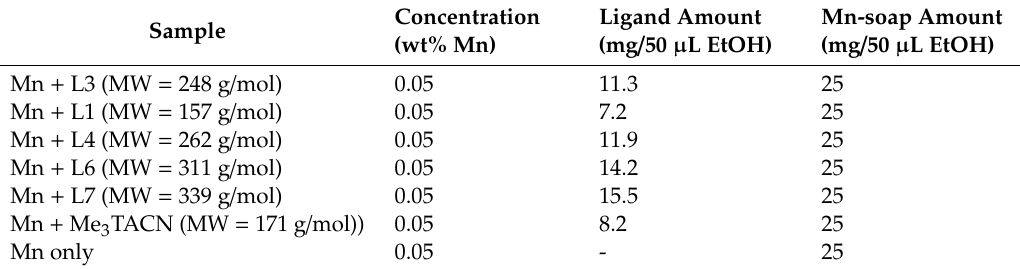
Table 1. Mn = the preparation of example ligands with Mn II (2-EH) 2 (as the Mn) prior to formulation. The ligand numbers refer to those discussed in Figure 14. The dose of these catalysts in a formulation would then be calculated and set as a %Mn content versus formulation mass for comparison